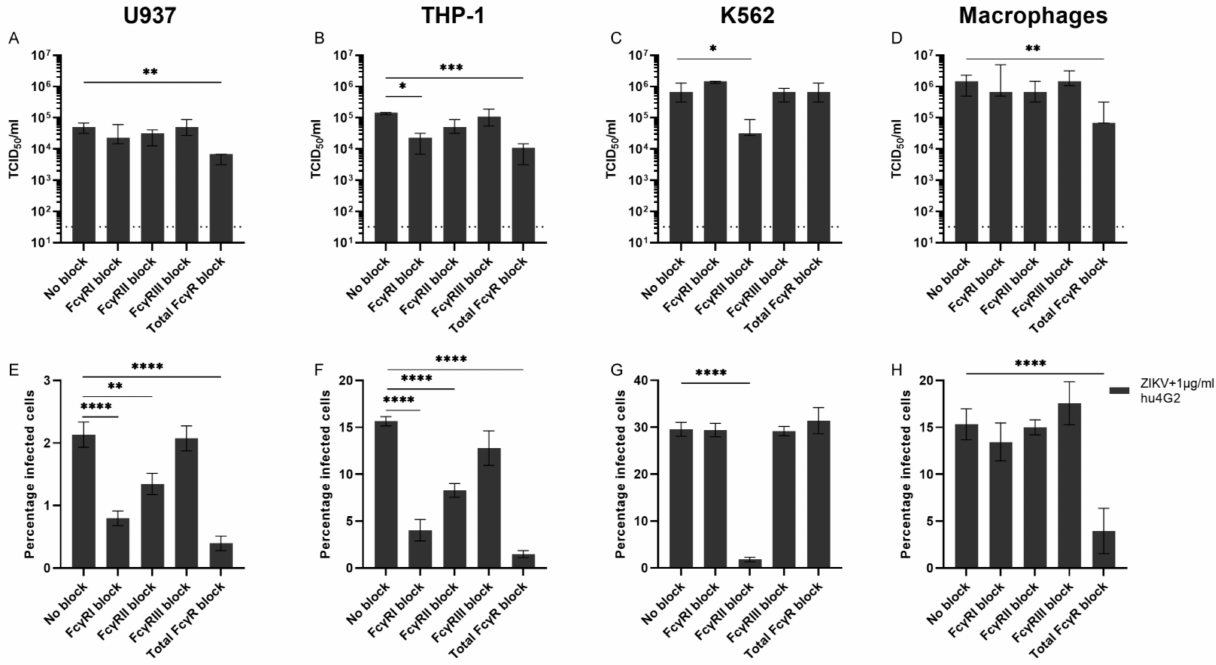
Figure 4. Fc γ RI and Fc γ RII contribute to ADE of ZIKV infection in Fc γ R cell lines and primary cells. Fc γ R-bearing human cell lines and myeloid cells that are permissive to ADE of ZIKV infection were pre-incubated with monoclonal antibodies against Fc γ Rs or with Human BD Fc Block before adding ZIKV (MOI 0.5) that was pre-incubated with 1 µ g/mL of the pan-flavivirus humanized monoclonal antibody 4G2 (hu4G2). Viral titers in supernatants were determined with titration ( A – D ) and the percentage of infected cells was determined with flow cytometry ( E – H ). Bars represent median titer ± IQR ( A – D ) and mean percentage of infected cells ± SEM ( E – H ). Statistical significance was determined with the Kruskal–Wallis test with Dunn’s post hoc test or a one-way ANOVA with Dunnett’s post hoc test, comparing the conditions with hu4G2 to infection with only ZIKV. * p < 0.05, ** p < 0.01, *** p < 0.001, **** p < 0.0001. N = 3 donors for monocyte-derived